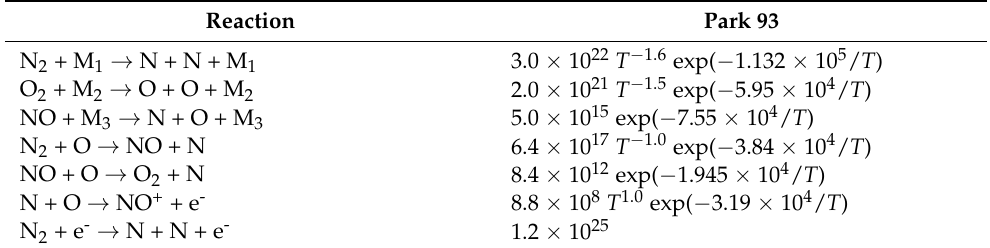
Table 1. Forward reaction rate coefficients in air-chemistry models (cm 3 /mole/s).